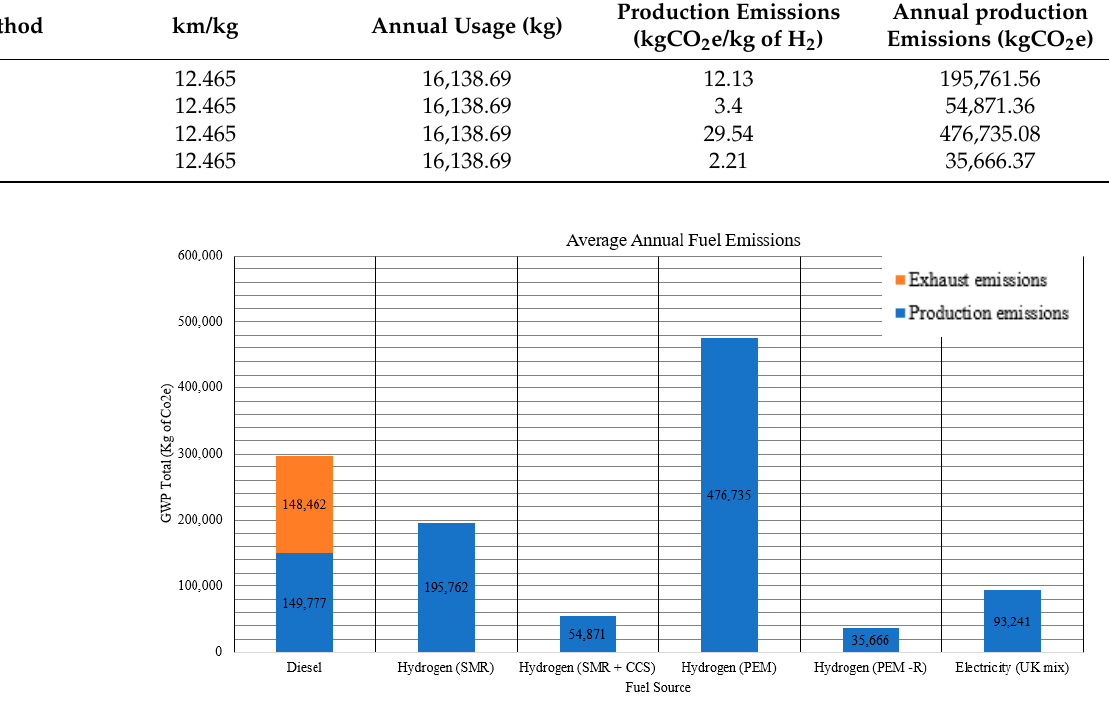
Figure 8. GWP of Different Fuel Production Methods.